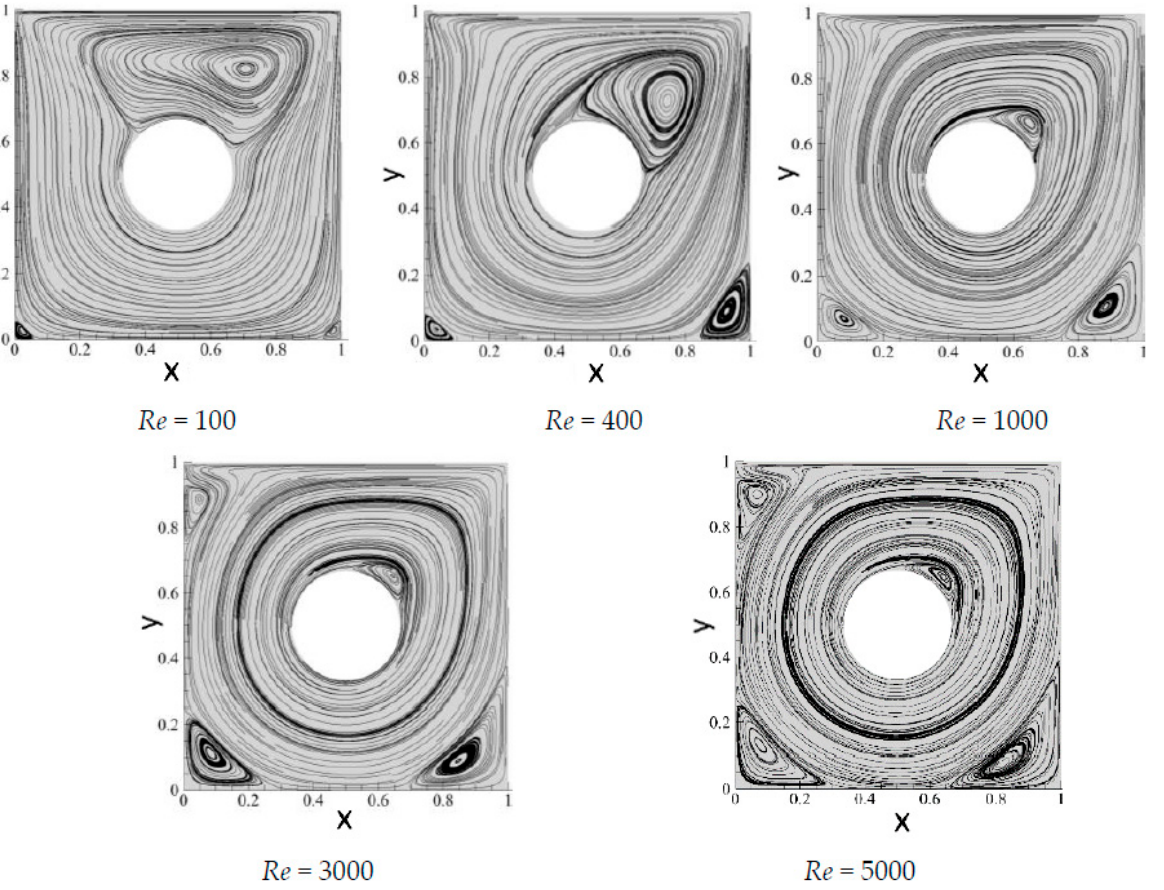
Figure 5. Streamlines of the lid-driven square cavity flow with an embedded circular obstacle at different Reynolds numbers Re at r =